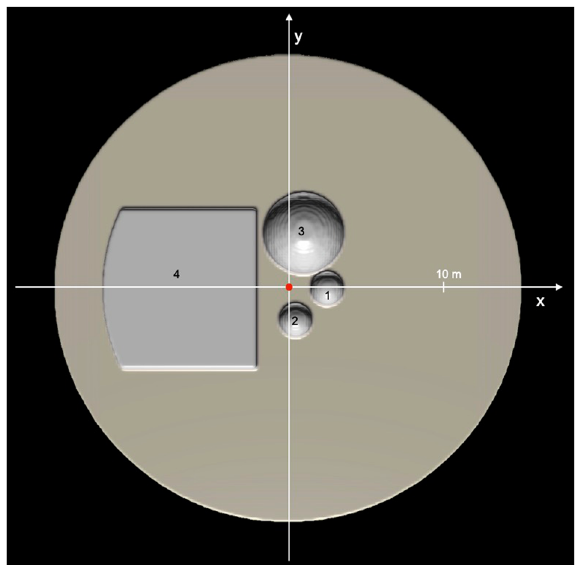
Fig.6|Boulderpositionsandimpactgeometry. Theimpactpointisinthecentre, marked bythe red dot. Thelocation anddimensionofthe boulders(1 – 4)aregiven in Table